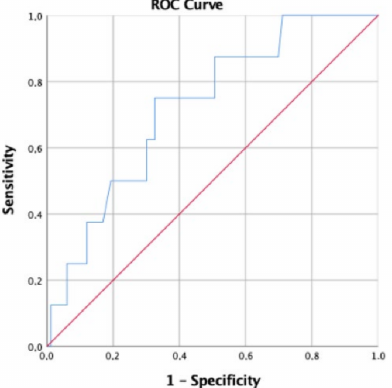
Figure 1. ROC curve for preoperative BR serum level and